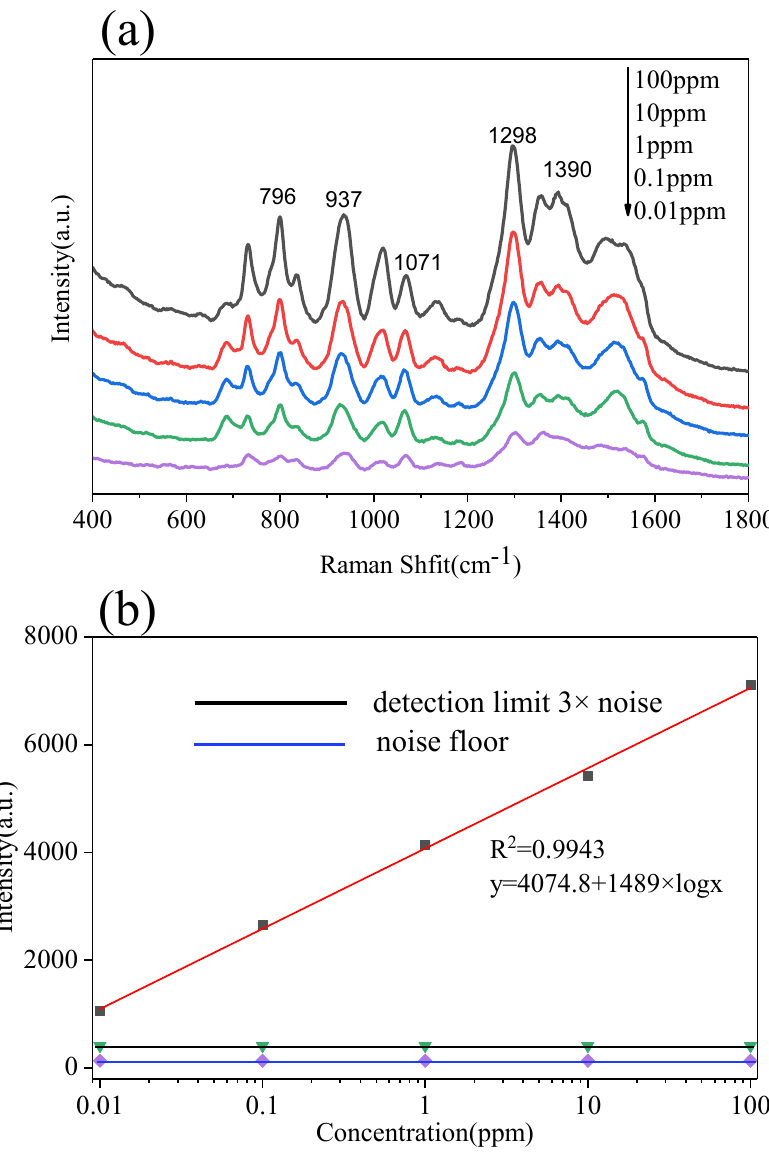
Figure 7. SERS spectra of DMZ at different concentrations from the LBL PS/Ag substrate ( a ), Raman intensity as a function of the logarithm of DMZ concentration ( b ). Portable Raman spectrometer, laser λ = 785 nm, acquisition time: 2 s.